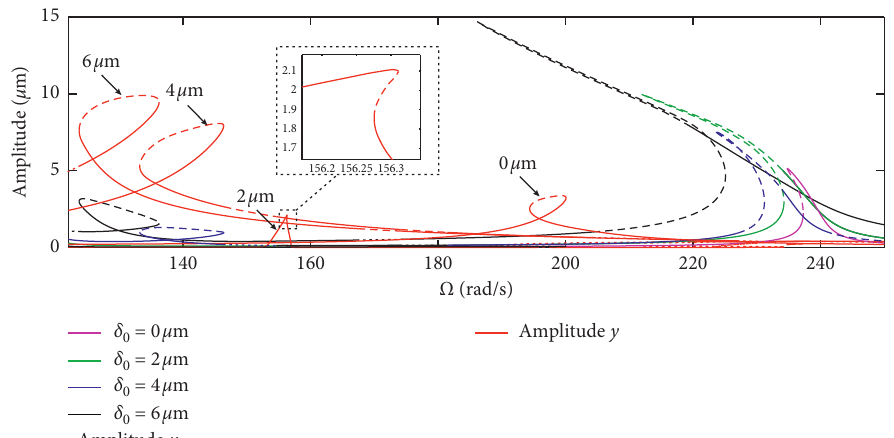
Figure 10: Influence of bearing clearance δ 0 on period-1 frequency-response peak-to-peak curves for c lines refer to stable and unstable responses, respectively.